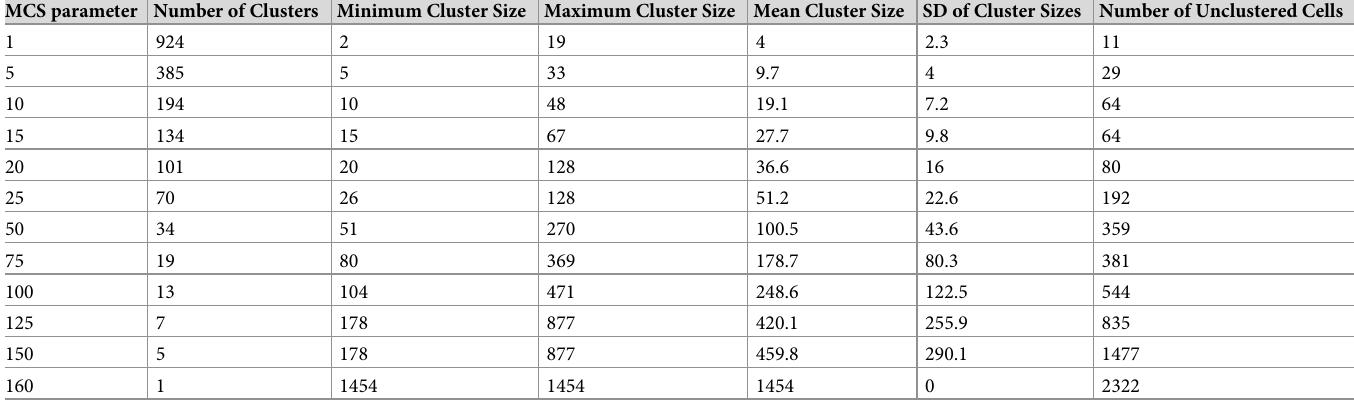
Table 4. Clustering details at various minimum cluster size (MCS) parameter values. The size of clusters was measured by the number of reef cells included in the